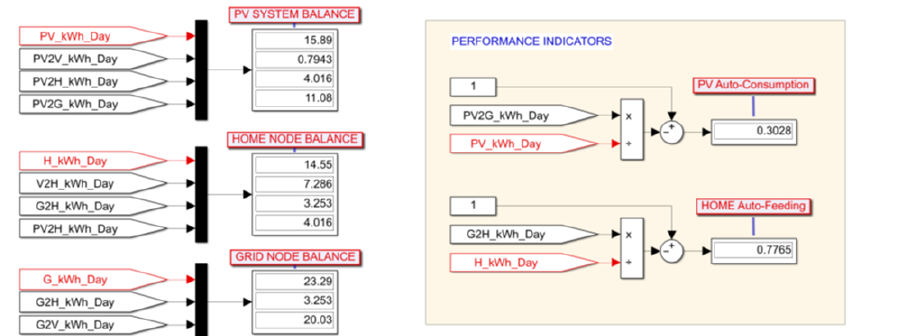
Figure 16. Energy balances at the main nodes ( left ) and performance indicators ( right ) for Case1B — OW 2D.